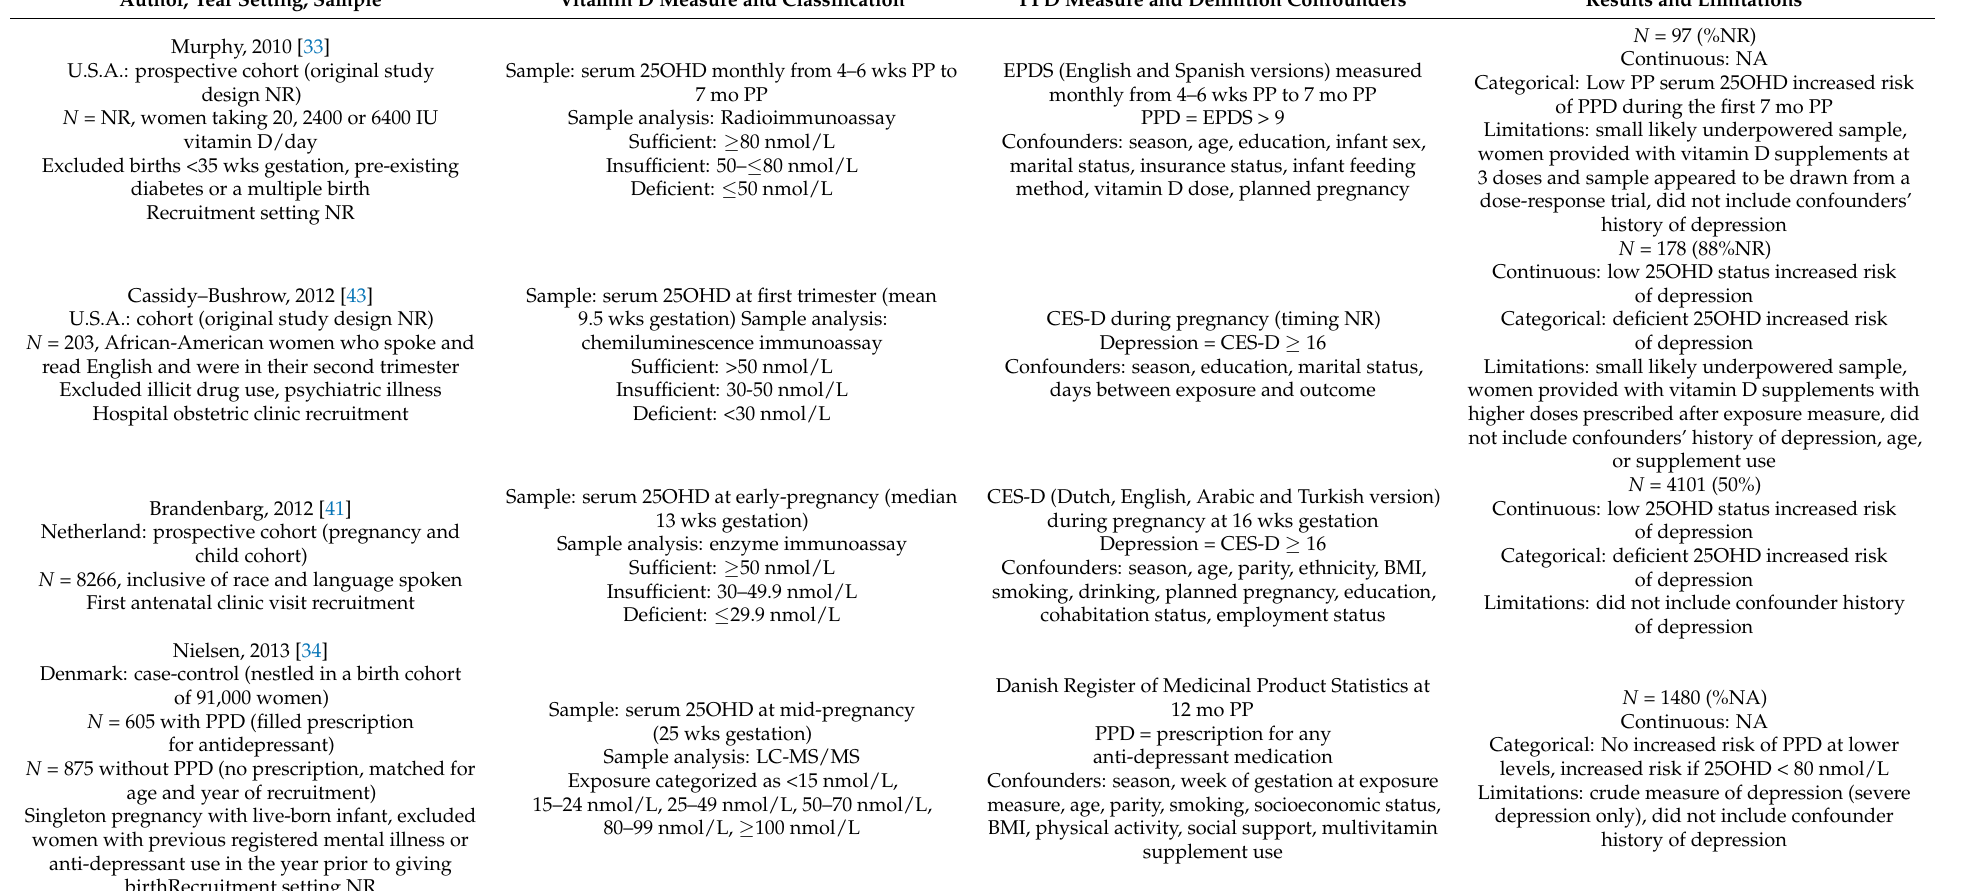
Table 2. Observational studies of vitamin D and symptoms of depression during pregnancy and